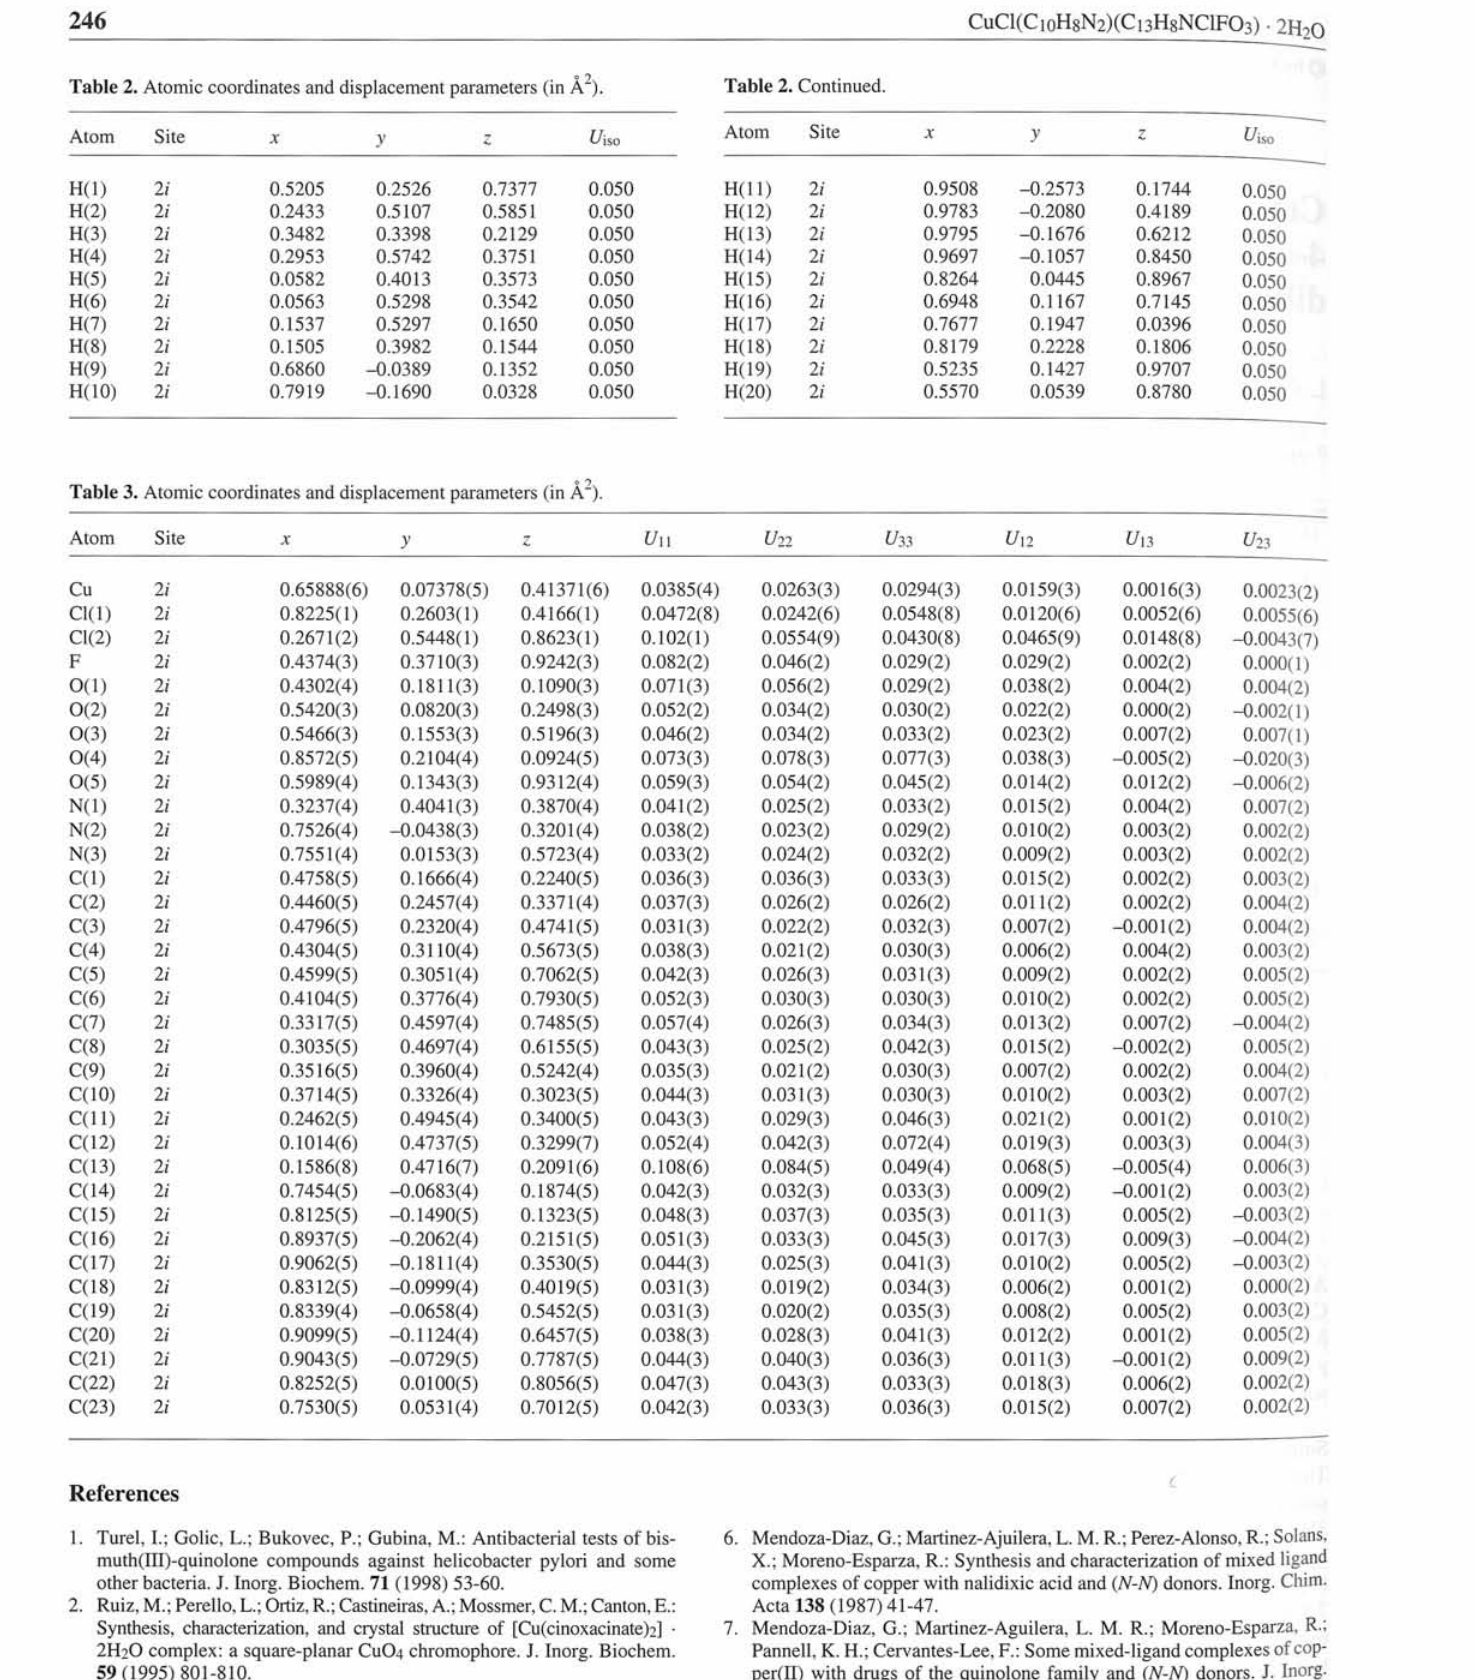
Table 2. Atomic coordinates and displacement parameters (in Á 2 ). Table 2. Continued.